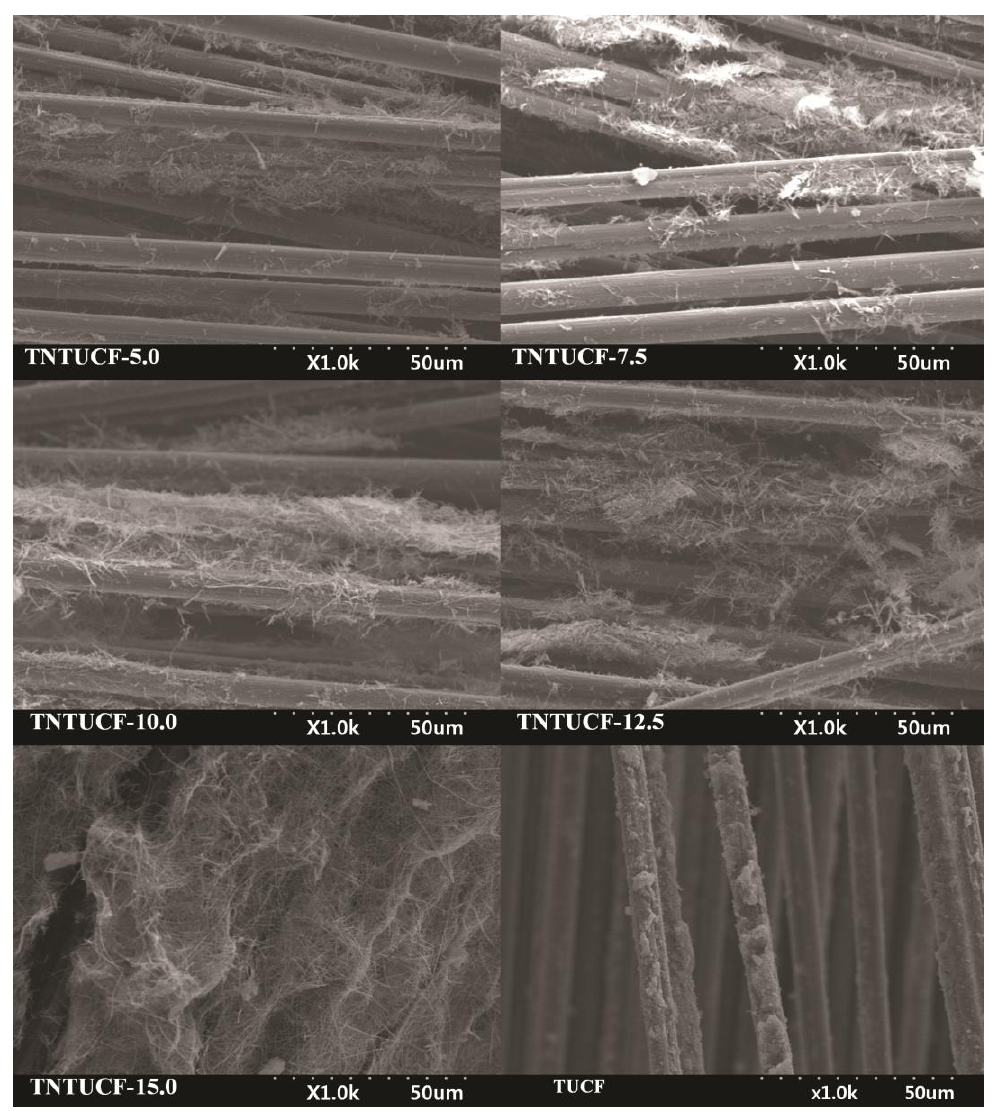
loadings (TNTUCF-5, 2